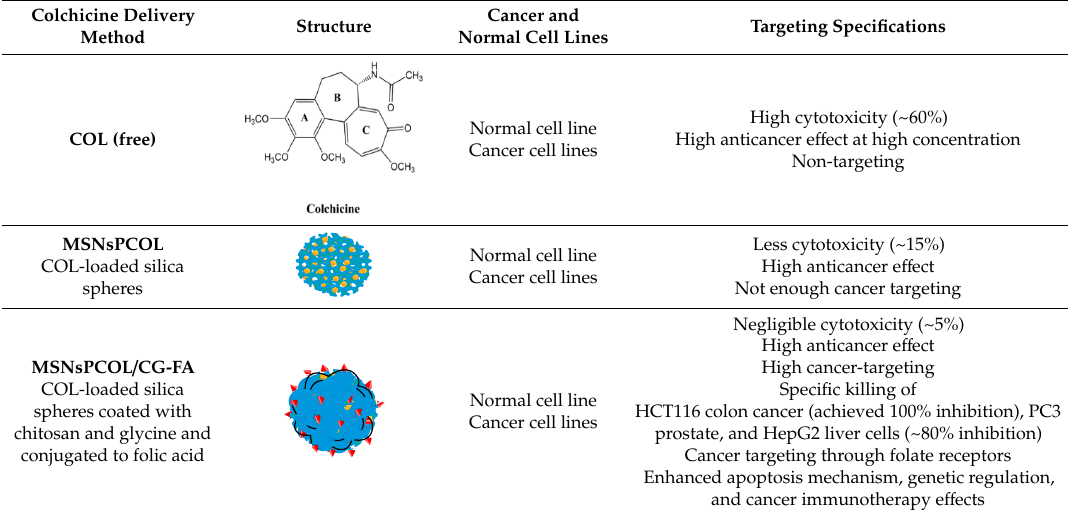
Figure 12. Schematic representation of cancer cell killing and possible anticancer mechanisms by which the proposed drug delivery system for colchicine (MSNsPCOL/CG-FA nanoformulation) acts in vitro against HCT116 colon cancer cells. Table 2. Summary of the results obtained for colchicine (COL) delivery methods.